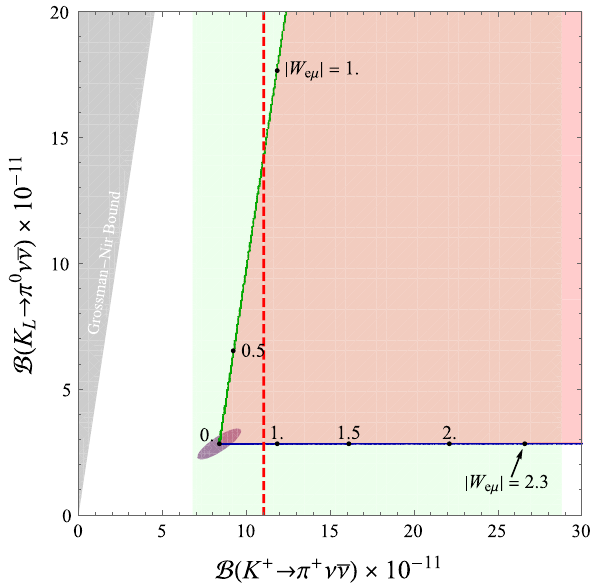
Fig. 3 New physics with lepton flavour violation. The pink shaded region is allowed for W e μ,μ e satisfying | W e μ,μ e | ≤ 6 with arbitrary phases. The left boundary of the region (green line) corresponds to the case W e μ = − W (cid:6) μ e , whereas the blue boundary (horizontal line) occurs for W e μ = W (cid:6) μ e . As before, the purple marks the SM 1 σ region, the green marks the 90% c.l. from BNL-787 combined with BNL-949 and the vertical dashed red line illustrates a possible future limit for B K + at 1.3 times the